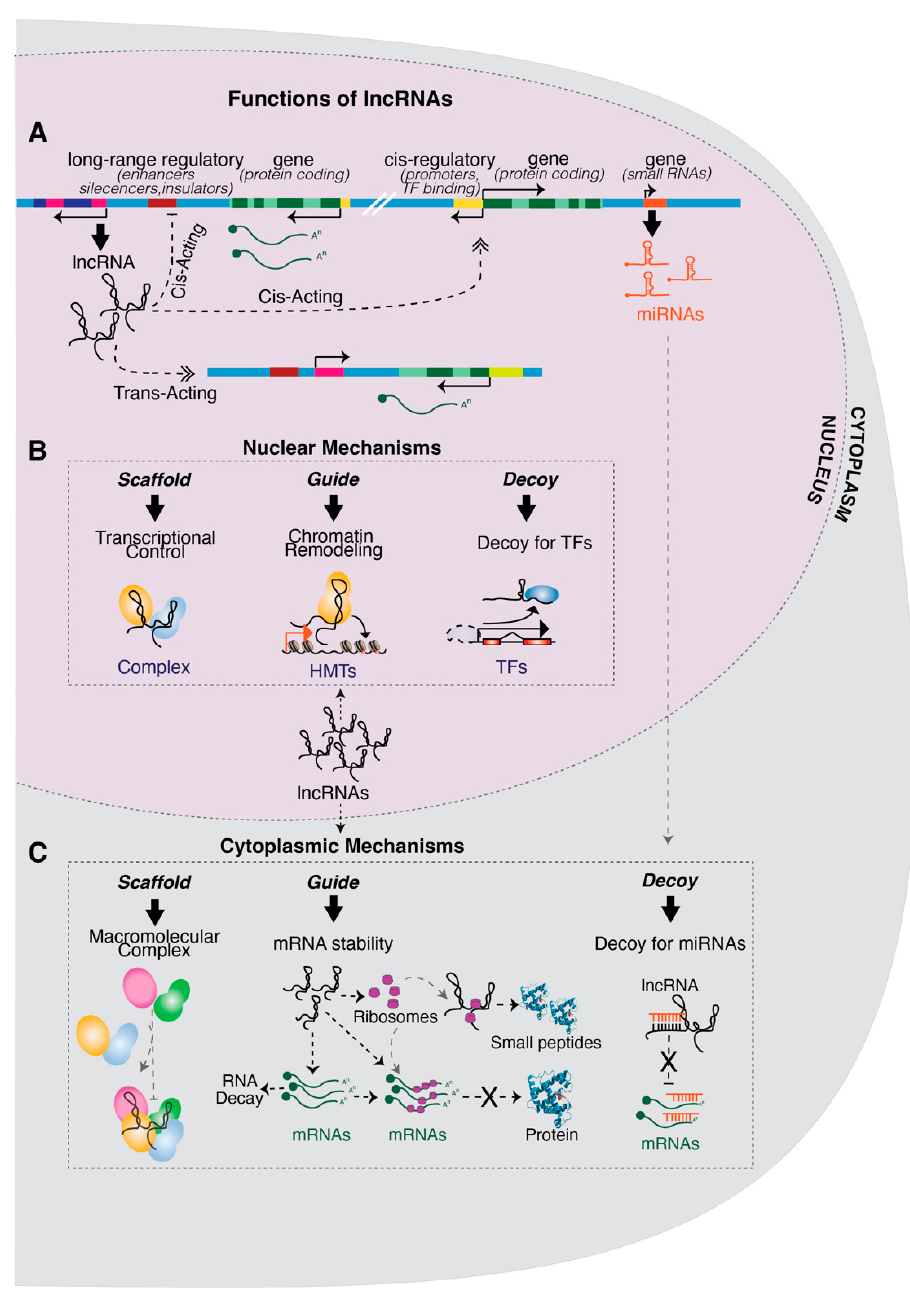
Figure 1. Genomic activity and molecular functions of lncRNAs: ( A ) the panel summarizes the possible modes of action of lncRNA, either in cis or in trans . The activity in cis is exerted on